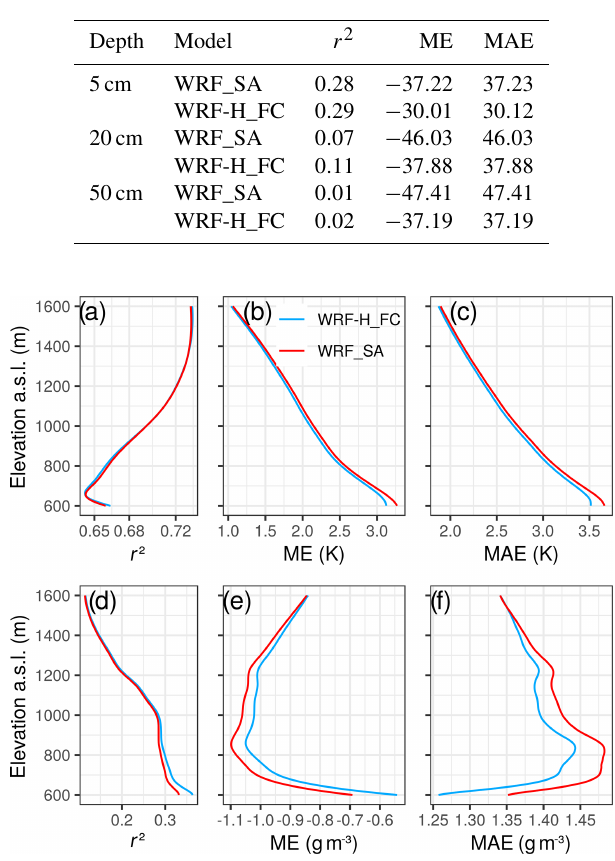
Figure 12. Performance evaluation of vertical atmospheric pro- files of air temperature (upper panel) and absolute humidity (lower panel) for the DE-Fen site for 1 June–31 July 2016. r 2 : coefficient of determination; ME: mean error; MAE: mean absolute error.